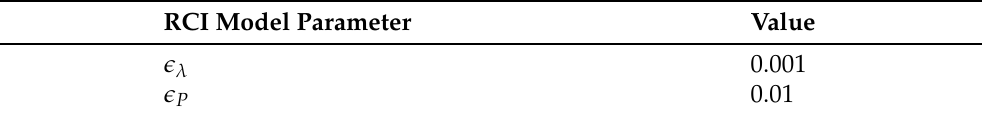
Figure 4. A 12-Bus LV Meshed distribution network consisting of prosumers. Table 2. Dual variable RCI convergence stopping criteria. A 12-Bus